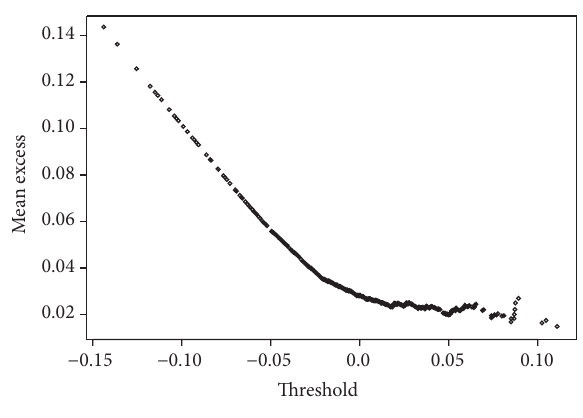
Figure 4: Empirical mean excess plot. Table 2: Estimates of GPD parameters and quantile of residuals 𝑧 𝑘 .